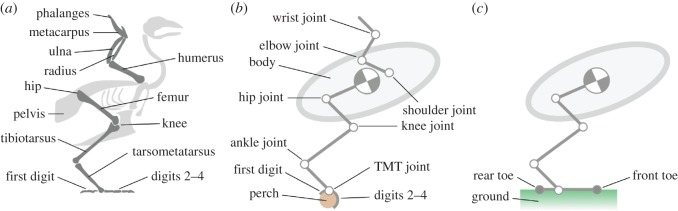
(a) Skeletal arrangement of the avian leg, body and wing. (b,c) Abstracted multi-body simulation model comprising rigid segments connected by actuated 1 d.f. revolute joints at the hip, knee, ankle, tarsometatarsal (TMT) joint and elbow, a 2 d.f. universal joint wrist, and a 3 d.f. spherical joint at the shoulder. (b) The perch model constrains the functional foot (digits) to remain stationary on the perch. (c) The ground model uses two contact points (filled circles) positioned at the rear and front toe to apply ground reaction forces when in contact with the ground. In the perch model (figure 7b), it is assumed that the functional foot can provide sufficient friction to prevent rotation around the perch, so the foot remains stationary throughout the jump. The perch model captures the countermovement and acceleration dynamics up until the time when the digits begin to disengage from the perch just prior to take-off.